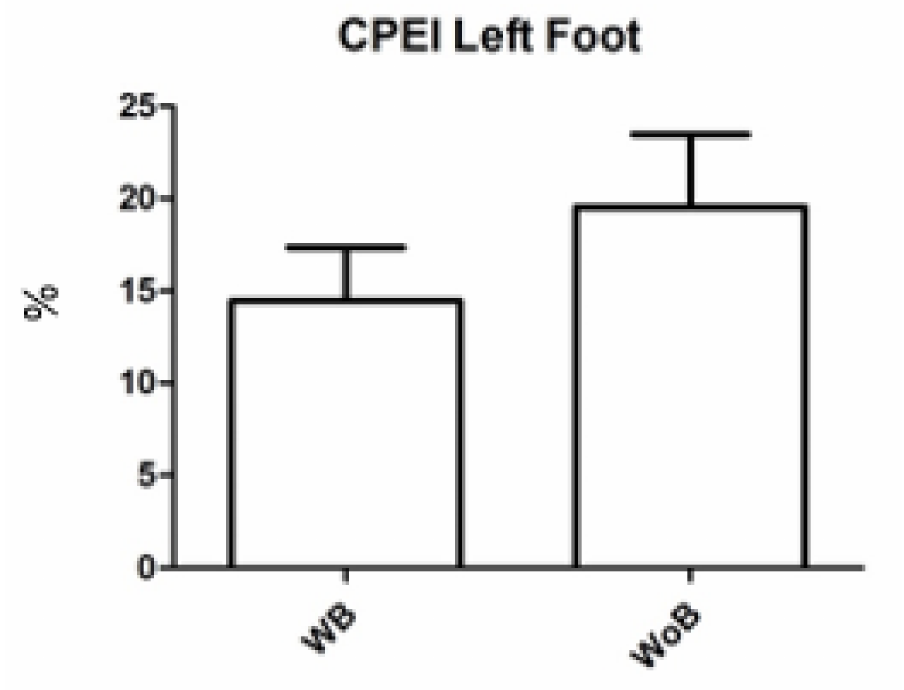
Figure 5. CPEI Left Foot with (WB) and without (WoB) brace.